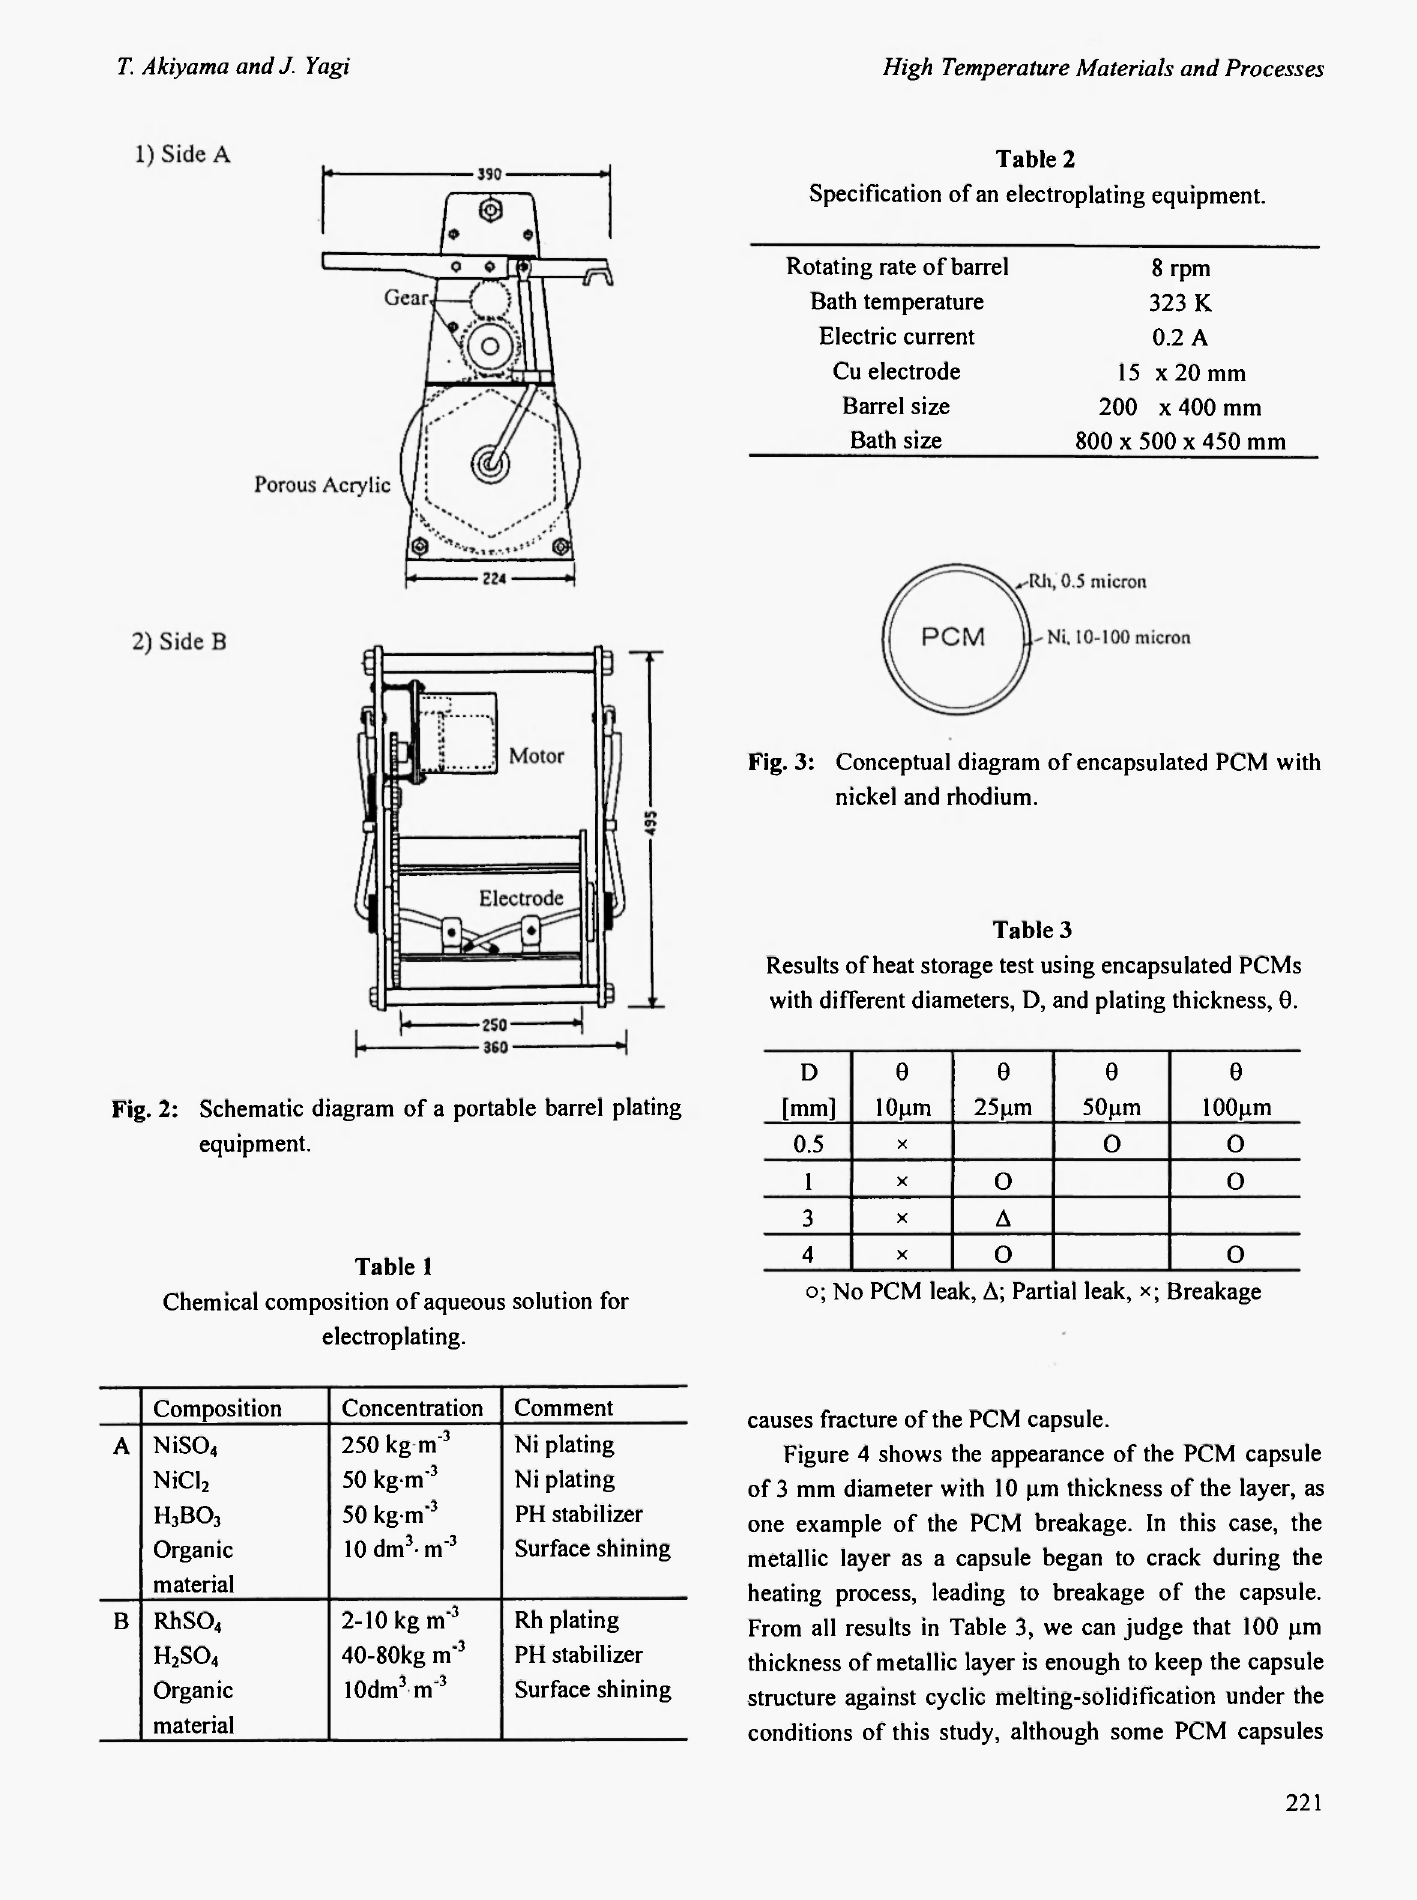
Chemical composition of aqueous solution for electroplating.